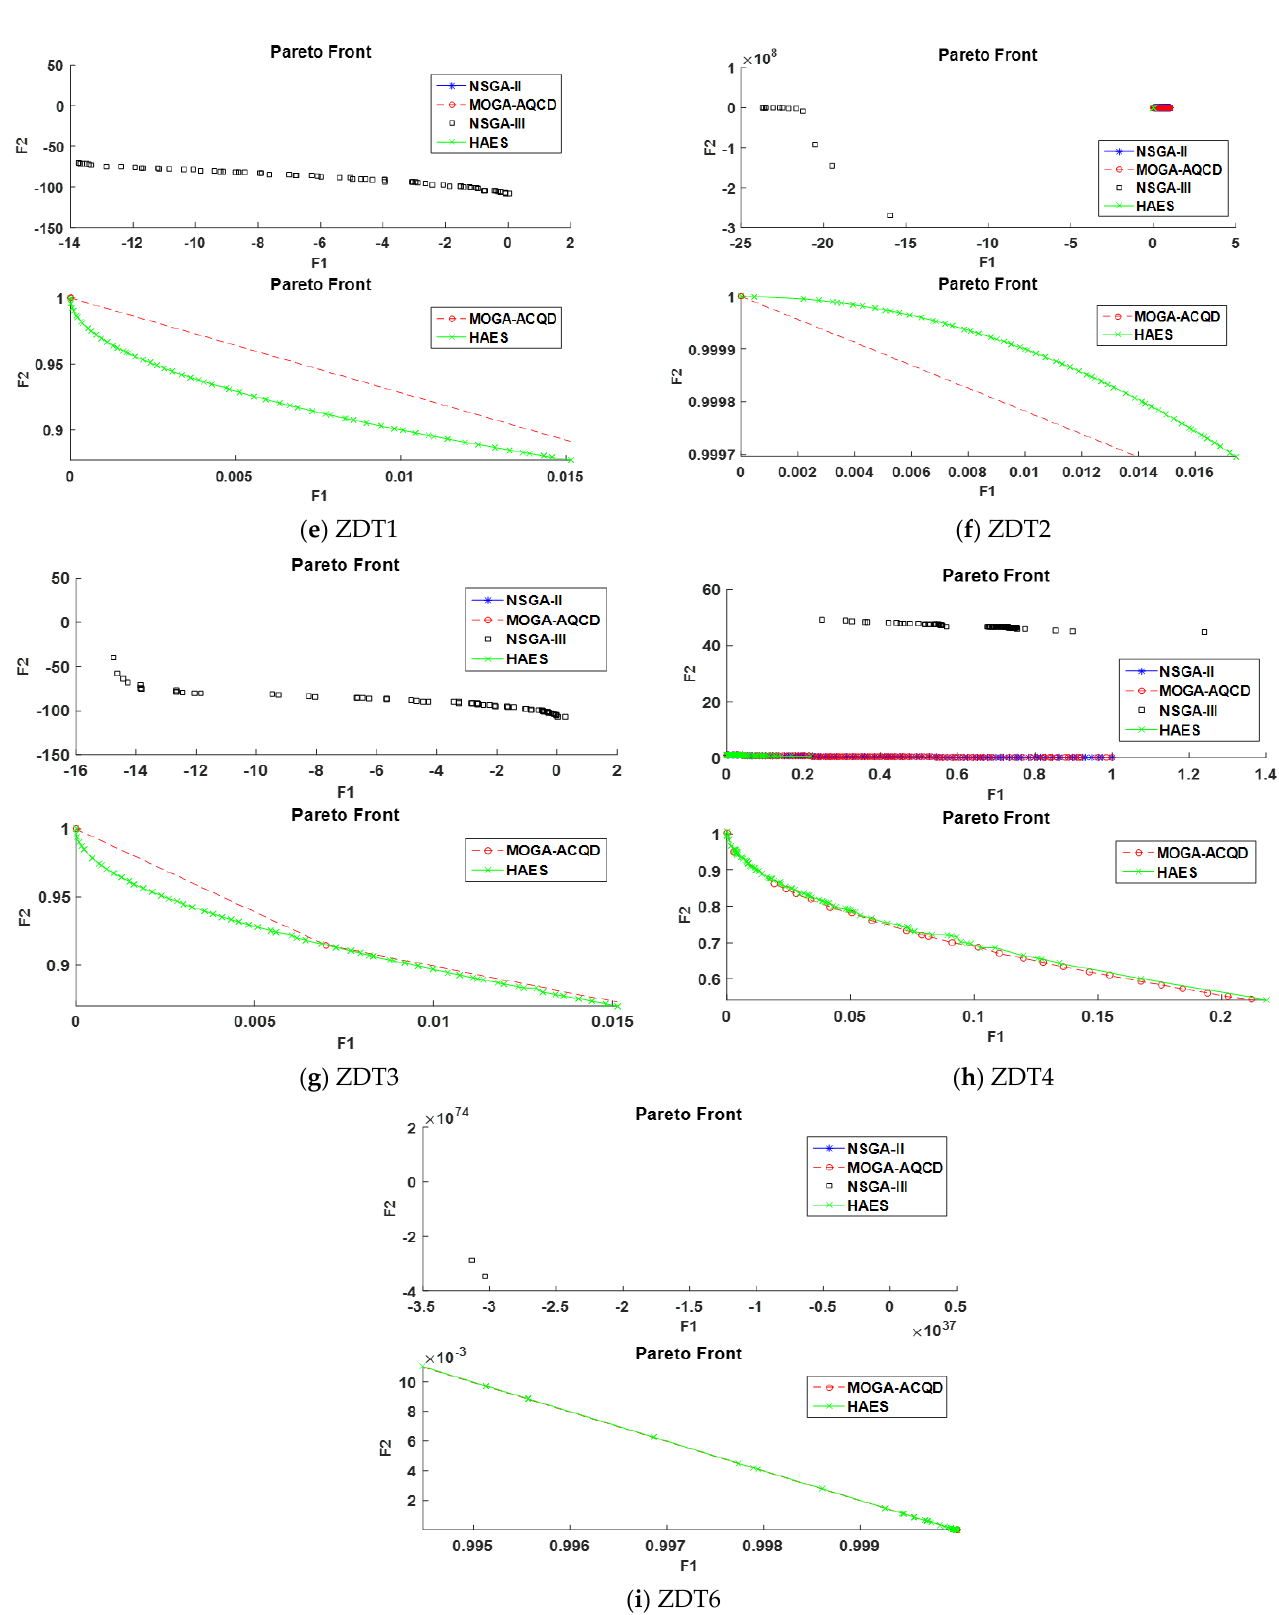
Figure 5. Pareto front with two scales: sub-figure HAES with MOGA-AQCD for FON, KUR, POL, SCH, ZDT1, ZDT2, ZDT3, ZDT4, and ZDT6.